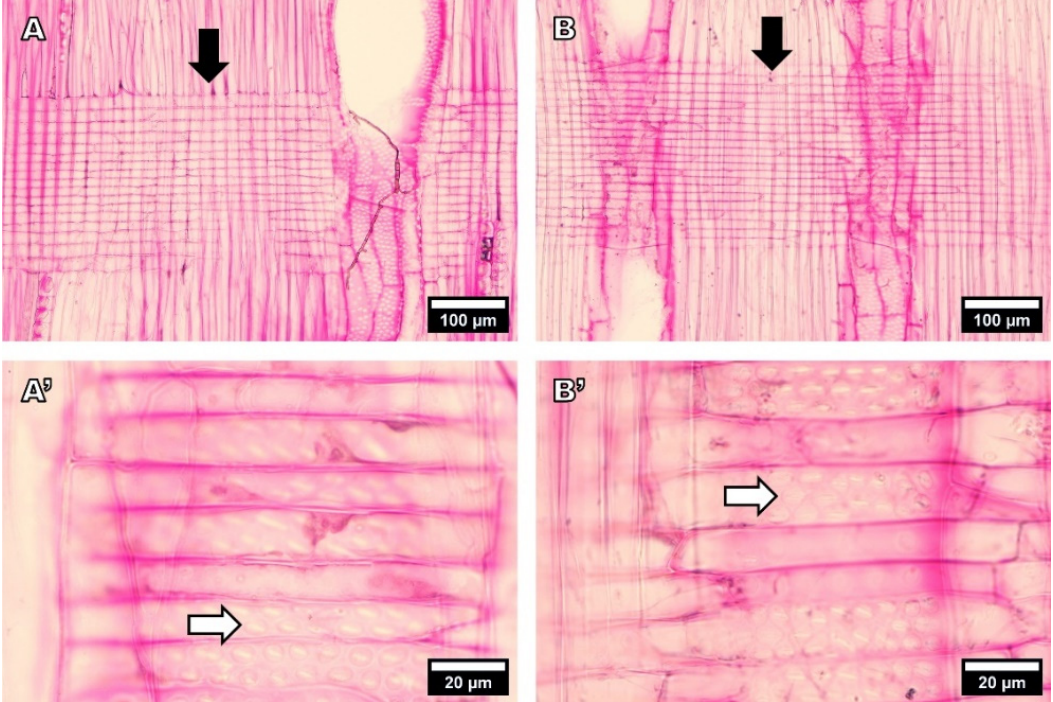
Figure 4. Optical micrographs of radial sections of Acacia mangium ( A , A’ ) and A. hybrid ( B , B’ ). Procumbent body ray cells (black arrow) and vessel-ray pitting (white arrow).